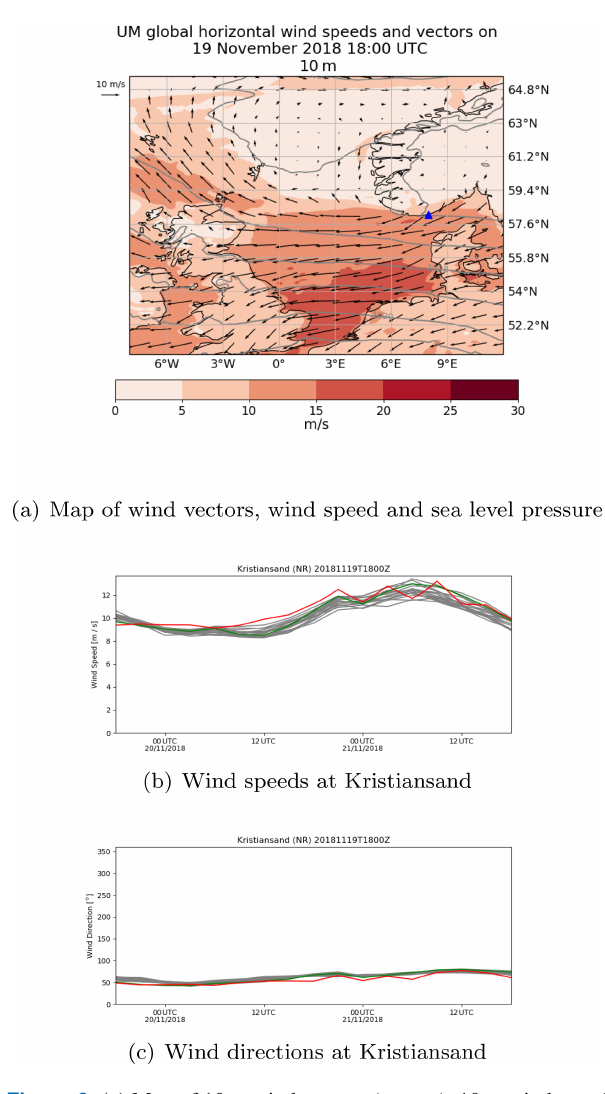
Figure 9. (a) Map of 10m wind vectors (arrows), 10m wind speed (red shading), and sea level pressure (grey lines) from the analysis meteorological data set at 18:00UTC on 19 November 2018. Kris- tiansand (Norway) is marked with a blue triangle. (b) 10m wind speed and (c) 10m wind direction at Kristiansand (Norway) from the ensemble forecast (grey lines), deterministic forecast (green line), and analysis meteorology (red